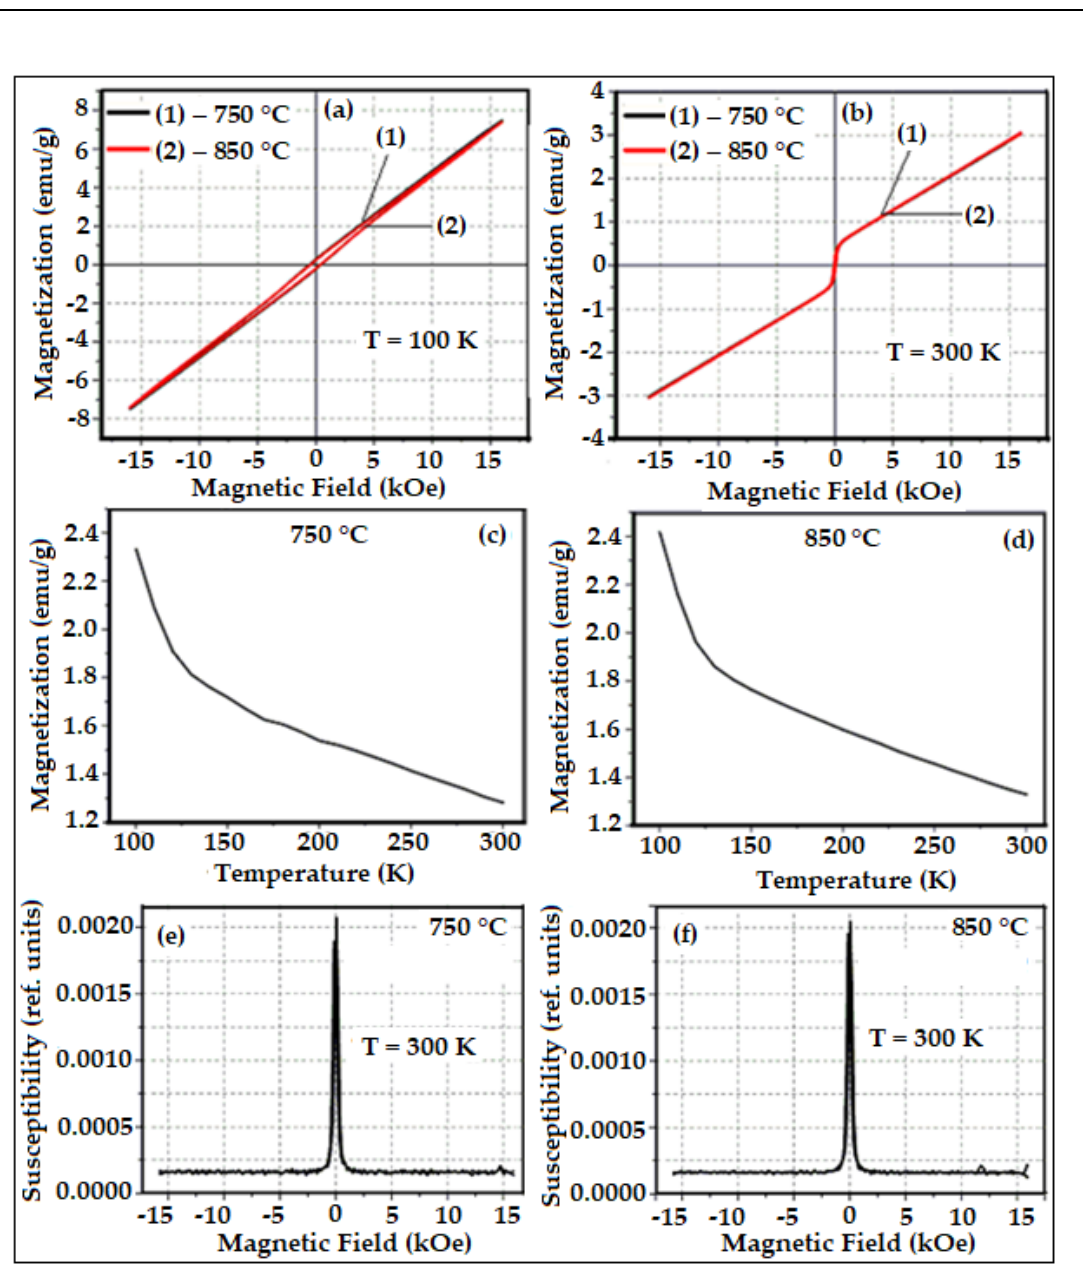
Figure 4. Magnetization versus applied field plots of HoFeO 3 nanoparticles at 100 K ( a ) and 300 K ( b ); Temperature dependence of zero-field-cold (ZFC) magnetization ( c , d ), and ( e , f ) susceptibility plots of HoFeO 3 nanoparticles at 300 K.